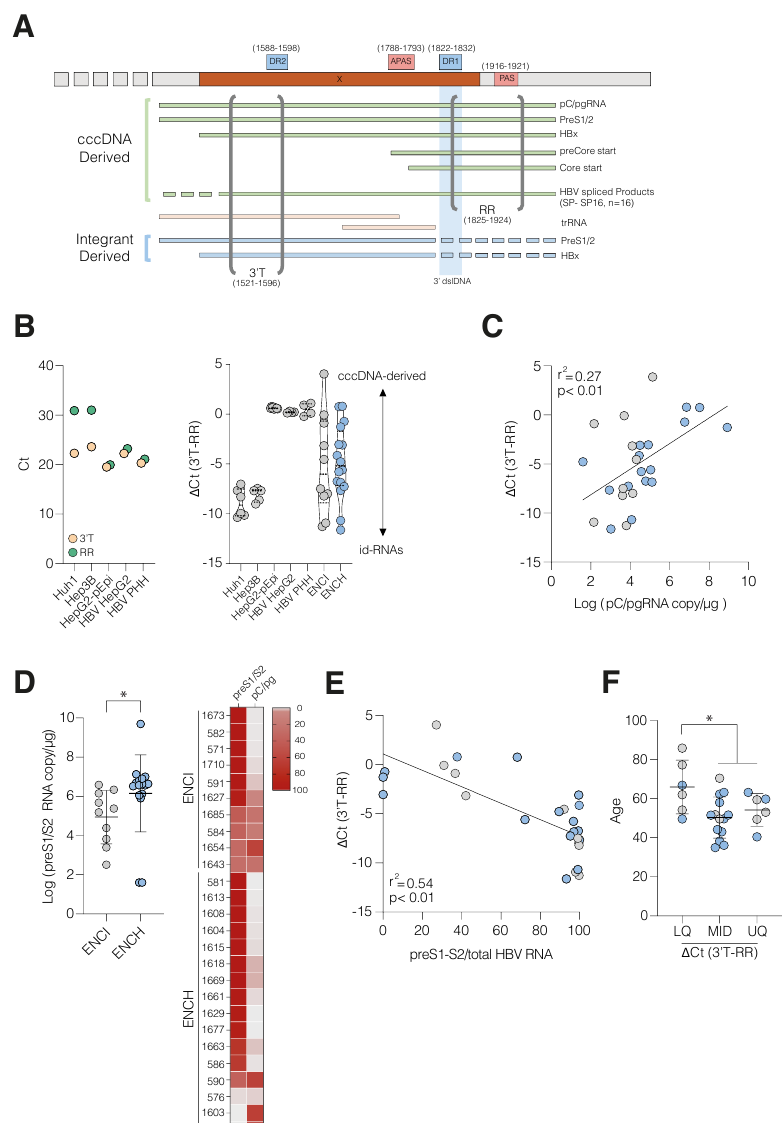
Figure 3. Quantification of HBV cccDNA and integrant-derived transcripts. ( A ) Graphic depicting HBV cccDNA- and integrant-derived transcripts; location of HBx ORF (X); direct repeats 1 and 2 (DR1 and DR2); the primary and alternative (cryptic) polyadenylation signals (PAS and APAS); 3 (cid:48) end of double stranded linear genome (3 (cid:48) dslDNA) and the regions amplified by 3 (cid:48) T and RR primers with coordinates shown. ( B ) PCR Ct values of 3 (cid:48) T or RR primers on amplification of cDNA isolated from HBV integrant lines (Hep3B, Huh-1, n = 6); HepG2 with episomal HBV DNA (HepG2-pEpi, n = 4); HBV-infected HepG2-NTCP cells or PHHs (3 days post-infection, n = 4) ( left ). ∆ Ct (3 (cid:48) T-RR) of cell culture systems and CHB liver biopsies from ENCI (grey symbols) or ENCH (denoted in blue symbols). Each symbol represents the mean value from 2 technical PCR replicates, where the median and quartiles are shown ( right ). ( C ) Association between pC/pg RNA and ∆ Ct (3 (cid:48) T-RR) value was assessed using Spearman correlation coefficient. ( D ) preS1/S2 RNA copies in ENCI and ENCH ( left ) and relative pC/pg and preS1/S2 RNA levels in CHB expressed as a percentage of the total RNA ( right ), where the scale bar depicts the abundance of each transcript. ( E ) Association between preS1/S2 RNA and ∆ Ct (3 (cid:48) T-RR) value was assessed using Spearman’s correlation coefficient. ( F ) Association between patient age at the time of biopsy and ∆ Ct (3 (cid:48) T-RR) value. Patients were classified by ∆ Ct (3 (cid:48) T-RR) value based on the 25% (LQ); 25–75% (MID) and 75% (UQ) quartiles and significance assessed using a Mann–Whitney U-test comparing the LQ with MID and UQ groups (* p <